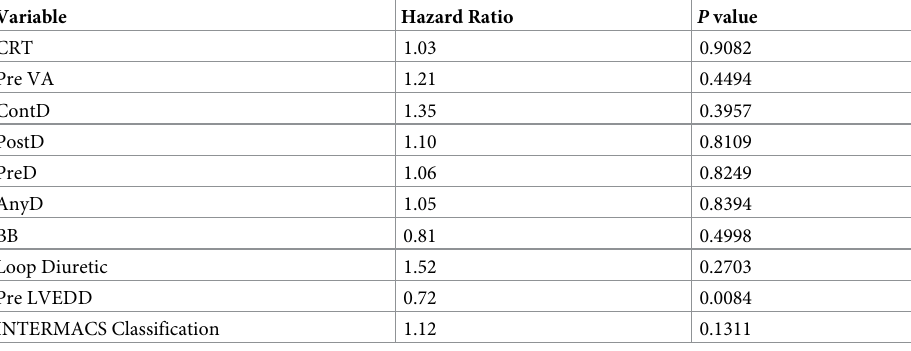
Table 3. Cox regression model for all cause